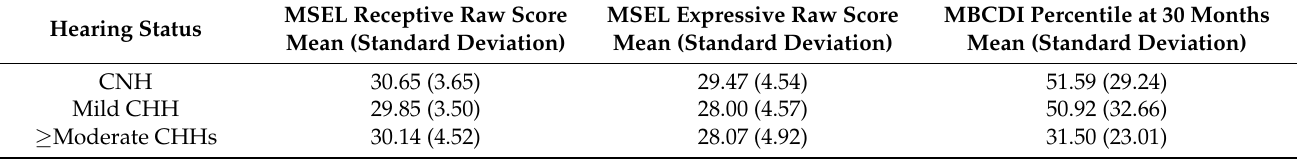
Table 9. Hearing Status, MSEL spoken Receptive and Expressive Raw Scores and MBCDI Percentile at 30